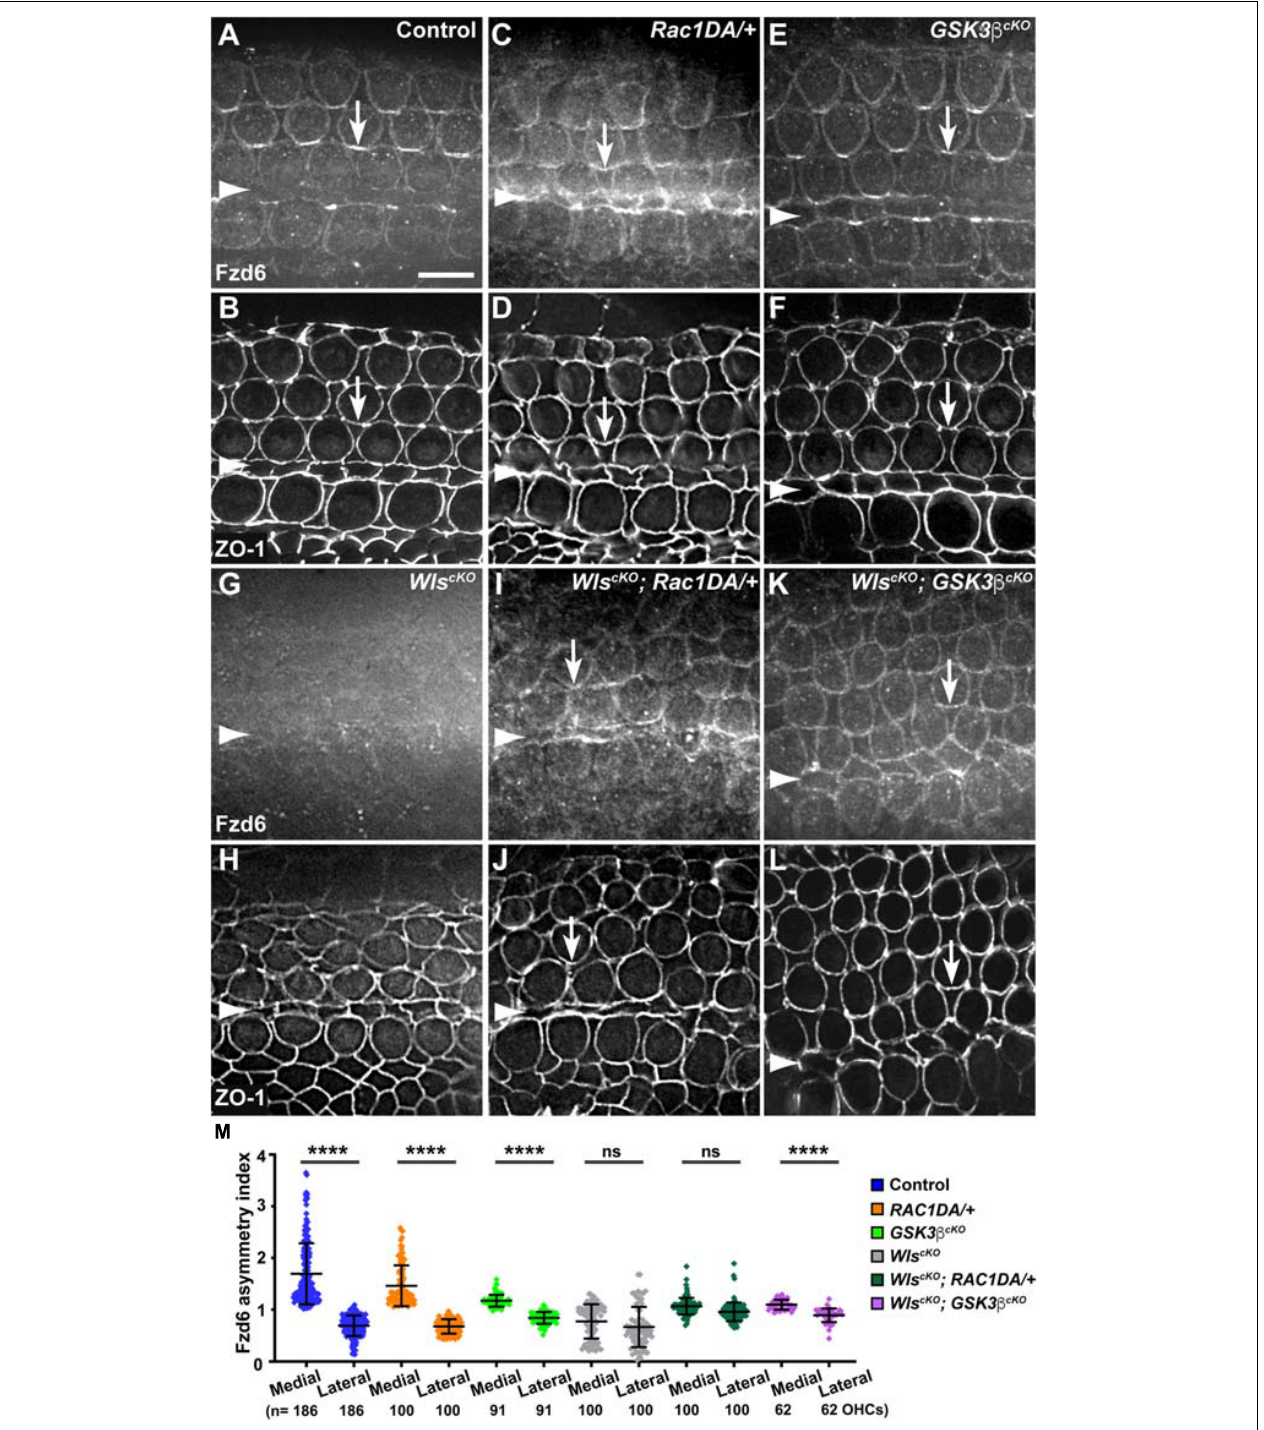
FIGURE 5 | Rac1 activation and Gsk3 β inactivation recovered Fzd6 junctional localization but not planar asymmetry in Wls-deficient OC. (A–L) Flat-mounted E18.5 wild-type control (A,B) , Rac1DA/ + (C,D) , Gsk3 β cKO (E,F) , Wls cKO (G,H) , Wls cKO ; Rac1DA/ + (I,J) , and Wls cKO ; Gsk3 β cKO (K,L) OC stained for Fzd6 and ZO-1 as indicated. Arrows indicate Fzd6 crescents along the medial borders of OHCs. Arrowheads indicate the inner pillar cell row. Lateral is up. Scale bar: 6 µ m. (M) Quantifications of Fzd6 staining along the medial and lateral junctions of OHCs. Numbers of OHCs scored are indicated on the bottom. Color keys for genotypes are indicated on the right. Ns, not